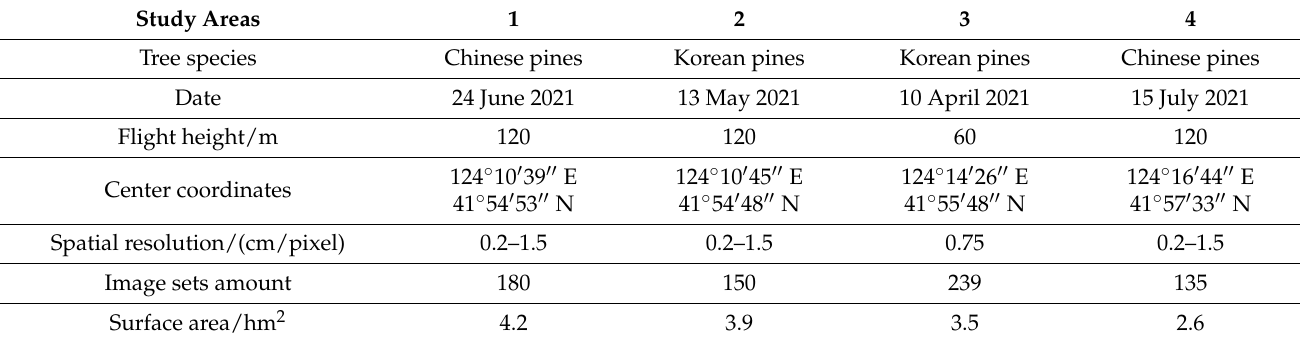
Table 2. Information on flight missions in study